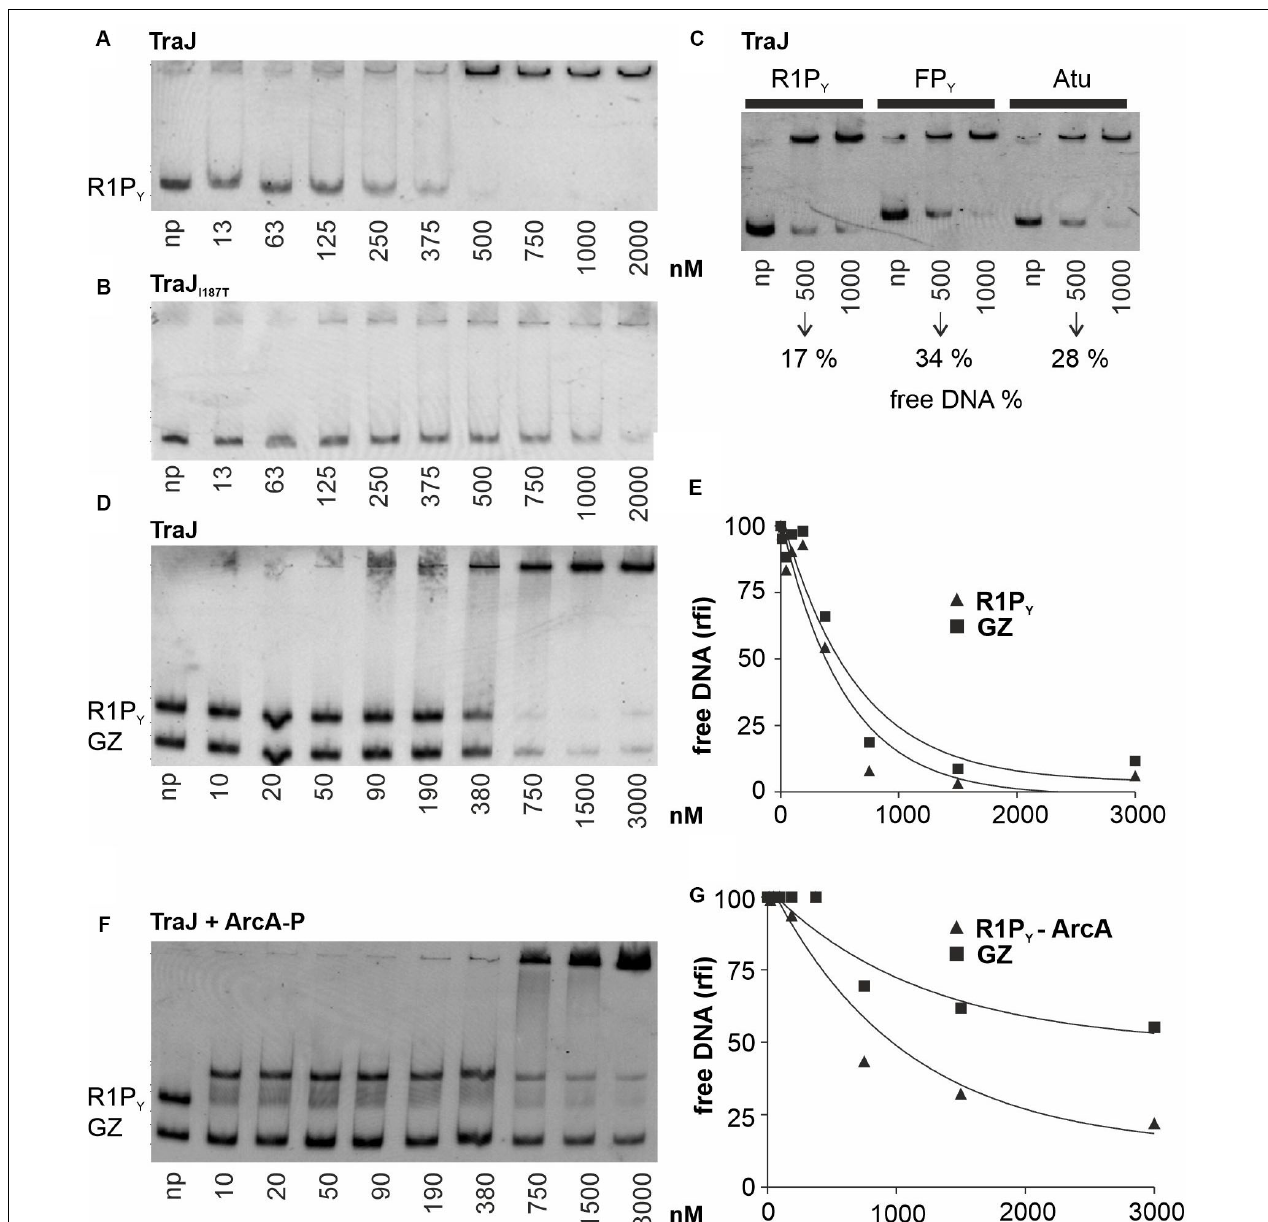
FIGURE 3 | EMSAs with various proteins and DNA fragments to characterize TraJ R1 binding to DNA. Binding studies were analyzed as described in Figure 2 . np, no protein added. (A) TraJ R1 binds to R1P Y DNA. No distinct DNA–protein complexes can be seen. The K d is estimated from this EMSA is 250 nM. At concentrations > 500 nM R1P Y DNA is shifted to the gel slot. (B) An activation deficient TraJ R1 mutant (I187T) displays a considerably weaker DNA binding activity with an apparent K d of 750 nM. (C) Comparison of TraJ R1 binding to different DNA fragments. TraJ R1 binds with higher affinity to R1P Y (319 bp) when compared to FP Y (422 bp) or a DNA fragment from Agrobacterium tumefaciens (Atu, 395 bp). (D) Simultaneous binding of TraJ R1 to R1P Y and a control fragment (GZ). TraJ R1 binds with higher affinity to R1P Y when compared to a control DNA. (E) The percentage of free R1P Y DNA and GZ DNA from D was calculated and graphically represented relative to the DNA fluorescence of the respective fragment without protein. (F) Pre-incubation of the DNA fragments (R1P Y and GZ) with 250 nM ArcA-P increases TraJ R1 preference for R1P Y DNA. (G) The percentage of R1P Y DNA bound to ArcA-P or free GZ DNA from F was calculated and graphically represented relative to the DNA fluorescence of the respective fragment without addition of TraJ R1 . The difference between TraJ R1 binding to R1P Y -ArcA-P versus binding to GZ when compared to E is clearly increased. rfi: relative fluorescence